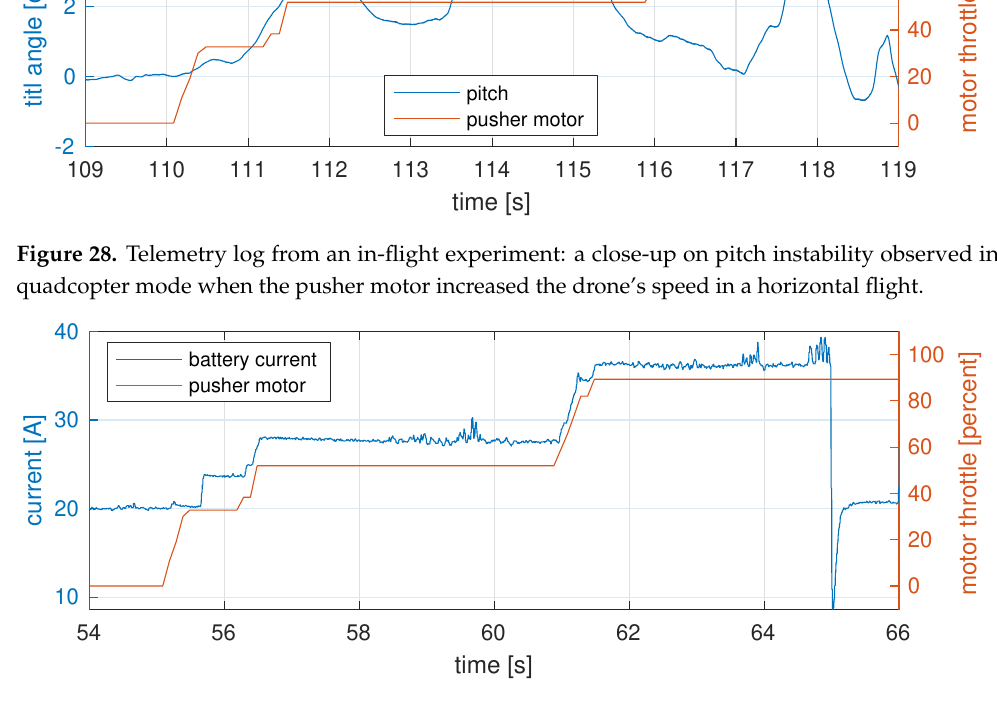
Figure 29. Telemetry log from an in-flight experiment: battery current readings in quadcopter mode (up to 55th second), accelerating with pusher motor (up to 65th second) and quadcopter motors shut down when fully transitioned into plane flight